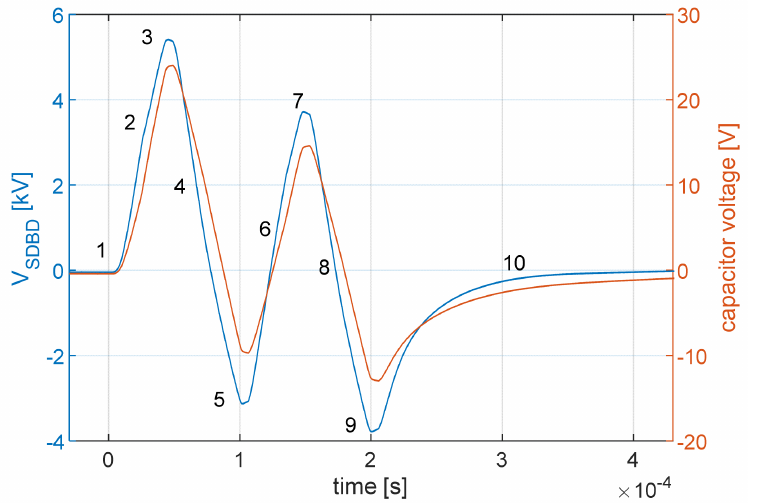
Figure 5. The voltage waveform of the SDBD plasma-seed treatment for nominal 8 kV peak-to-peak. The blue curve shows the voltage measured across the SDBD; the orange curve shows the voltage across the 68 nF series capacitor used to measure the charge on the electrode. The waveform distortion is caused by the transient response of the high-voltage amplifier when using high-frequency bursts. The numbers are used as references for Figure 6 to highlight specific key points.